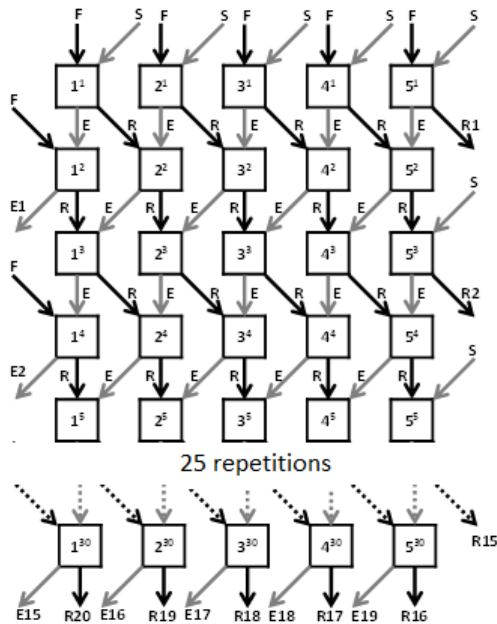
Figure 1. A schematic diagram of simulating a 10-stage countercurrent cascade with 5 separatory funnels: F: feed aqueous solution of the REEs, S: fresh organic phase, E: extract and R: raffinate.